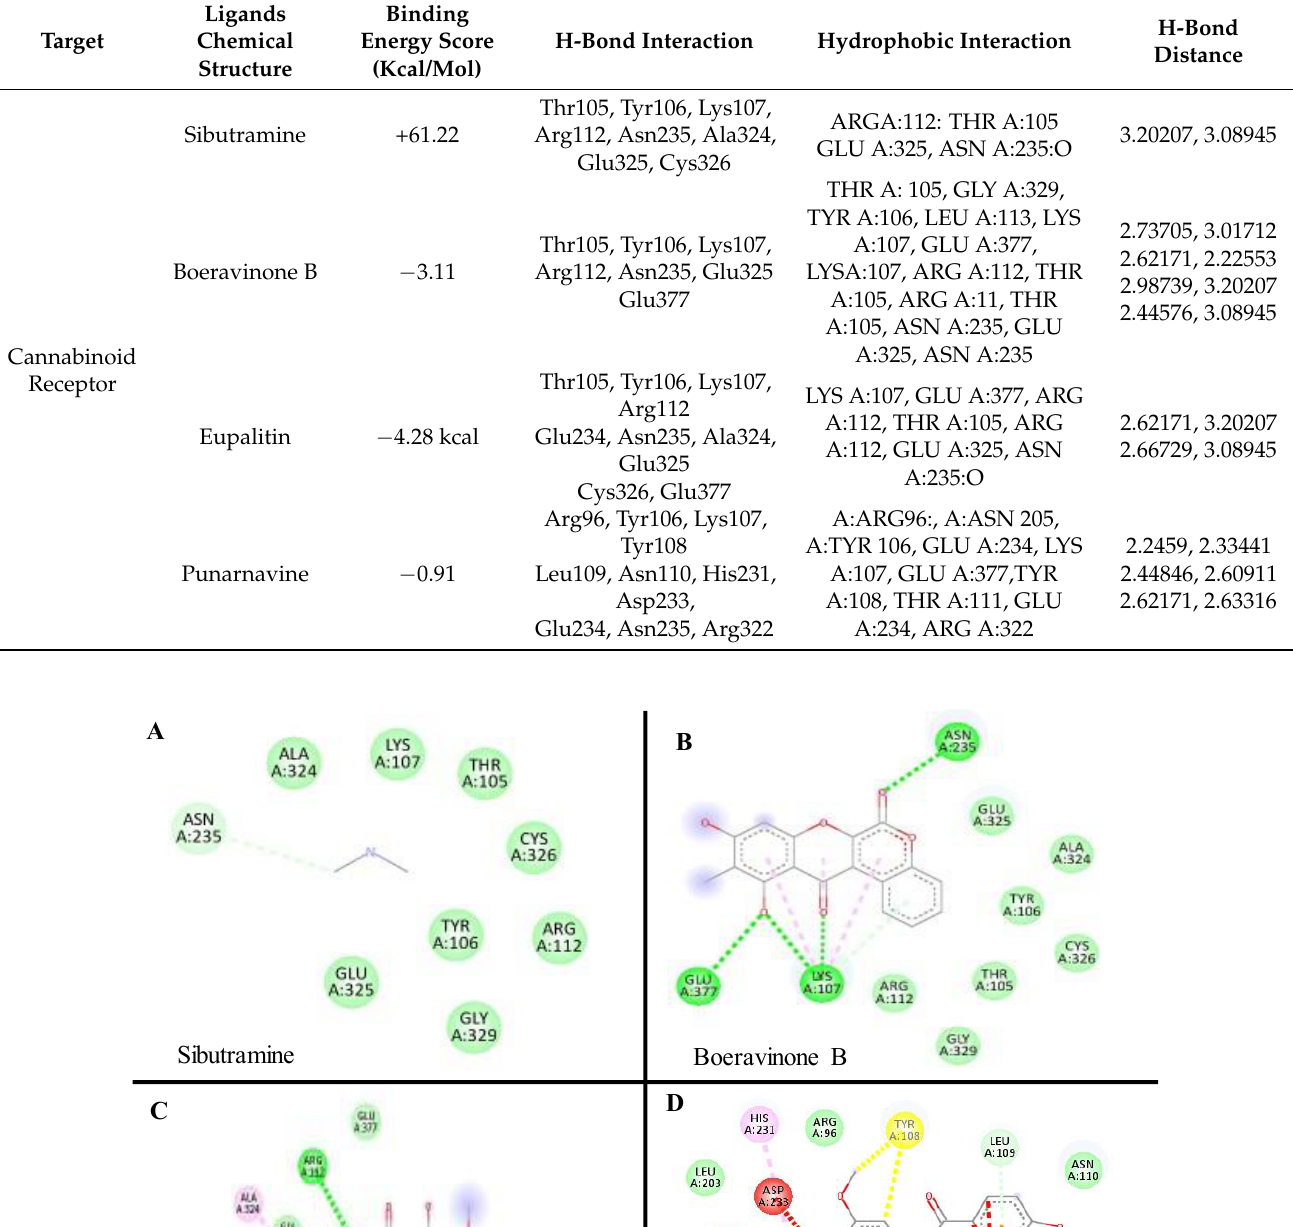
Table 4. The molecular docking revealed the possible binding mechanisms of Cannabinoid receptors with the selected compounds.